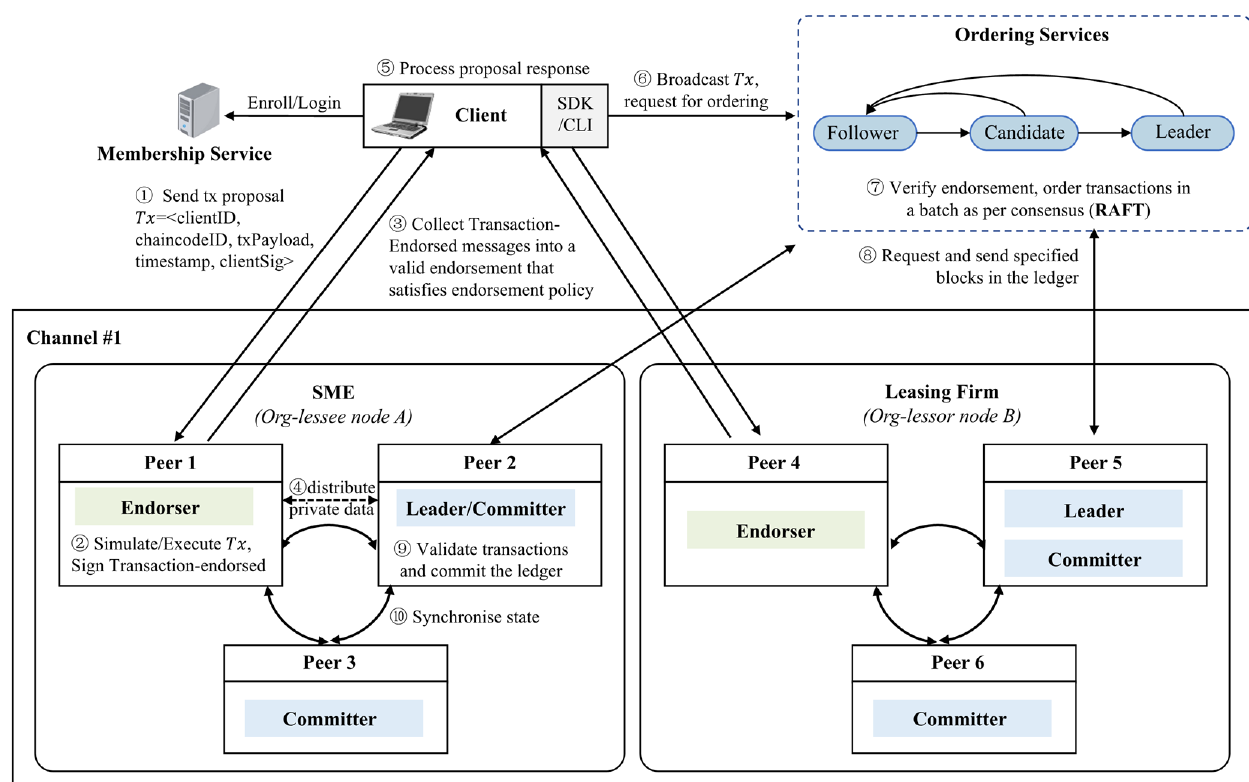
Figure 2. Transaction flow in Hyperledger Fabric with Raft consensus algorithm.